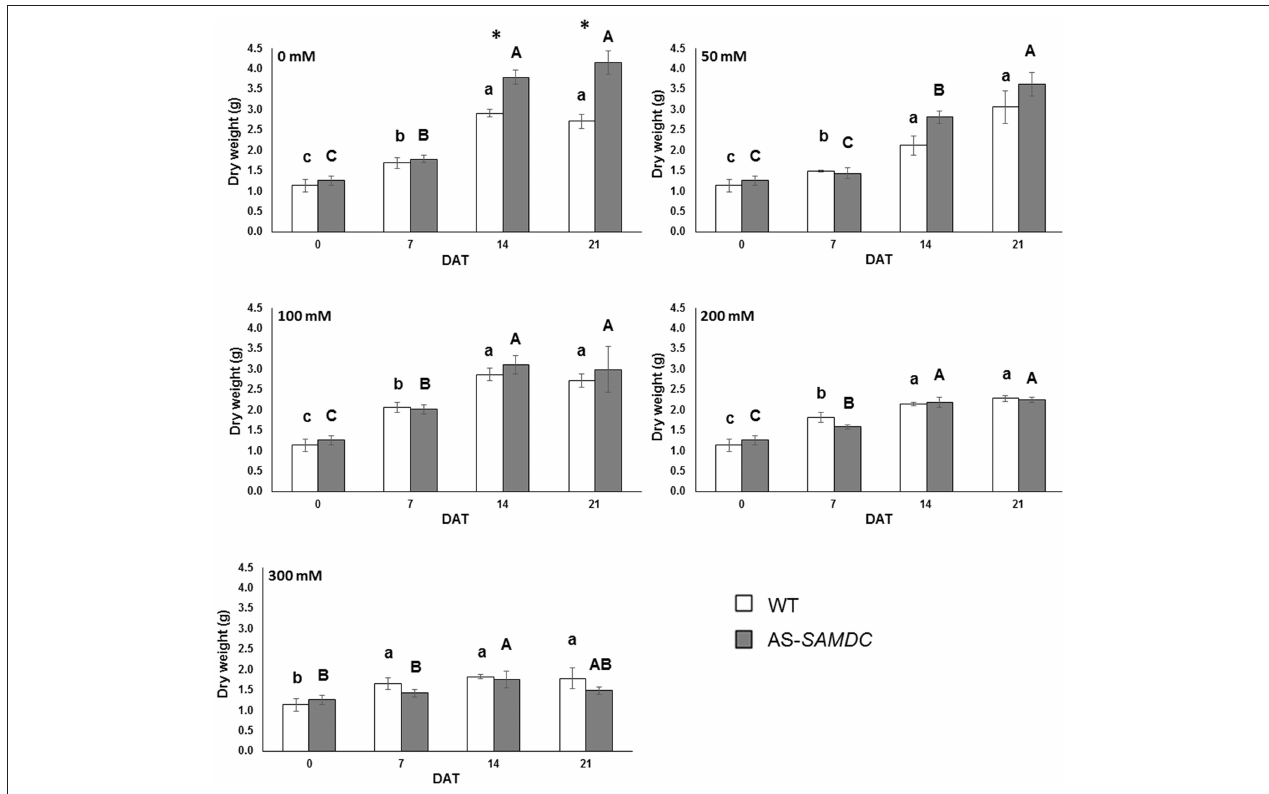
FIGURE 4 | Dry weight of WT and AS- SAMDC plants under control and NaCl treatment. Dry weight (g) at different NaCl concentrations (0, 50, 100, 200, 300 mM), 0, 7, 14, and 21 DAT. Data are means ± SE. Different letters (lower case for WT, upper case for AS- SAMDC ) indicate significant differences over time within the same genotype, based on Tukey’s HSD test ( P < 0.05). Asterisks indicate significant difference of mean values of AS- SAMDC from WT (Student’s t -test; * P <